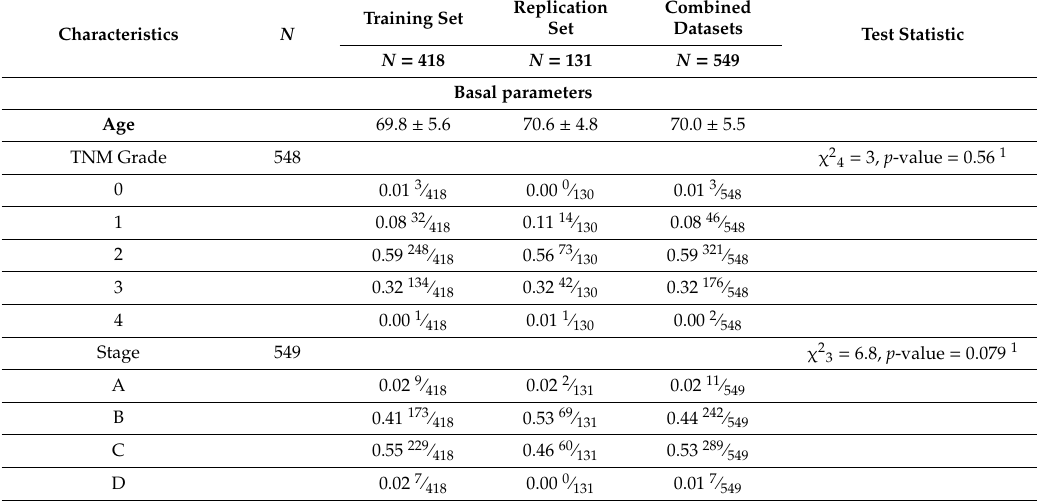
Table 1. Pathological characteristics of analyzed prostate cancer patients. Data from the training set, replication set, and combined datasets are reported. Statistical analyses were performed to evaluate whether training set and replication set were homogeneous. The results are reported